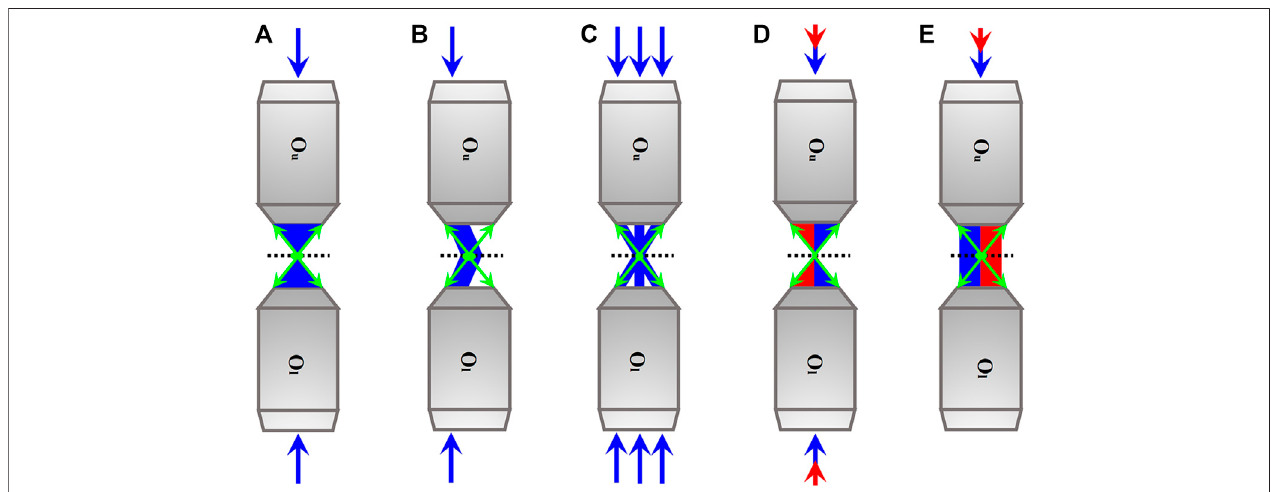
FIGURE 1 | Simpli fi ed schematics of axial SRFM methods. (A) – (C) Axial SRFM methods without relying on nanoscopy. According to their illumination modalities, they can be divided into scanning modality (A) , wide fi eld modality without (B) and with (C) laterally structured illumination. (D) and (E) Axial SRFM methods relying on nanoscopy.Accordingtotheirilluminationmodalities,theycanalsobedividedintoscanningmodalityinwhichsynchronizedexcitationlight(blue)andSTEDlight(red)are used for sharpening focal spot (D) and wide fi eld modality in which synchronized excitation light (blue) and activation light (red) are used for localizing the individual fl uorescent molecule sequentially (E) . Blue and green arrows indicate the directions of the excitation beam and fl uorescence. The directions of the STED light and activation light are both indicated by red arrows. The dotted line is at the sample plane. Ou, the upper objective lens; O l , the lower objective lens.